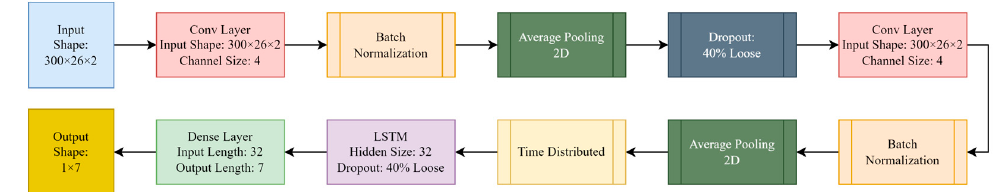
Figure 5. Classifier structure used in this paper, including array sizes and selected hyperparameters and functions.